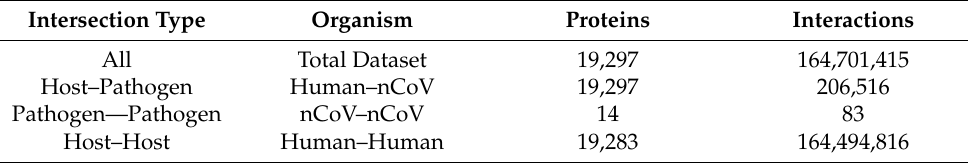
Table 2. Detailed statistics of Human–nCoV protein interactions computed by our proposed